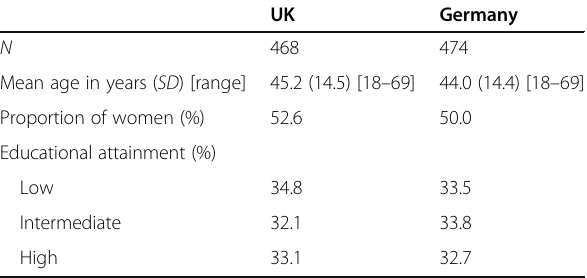
Table 1 Sample characteristics, UK and